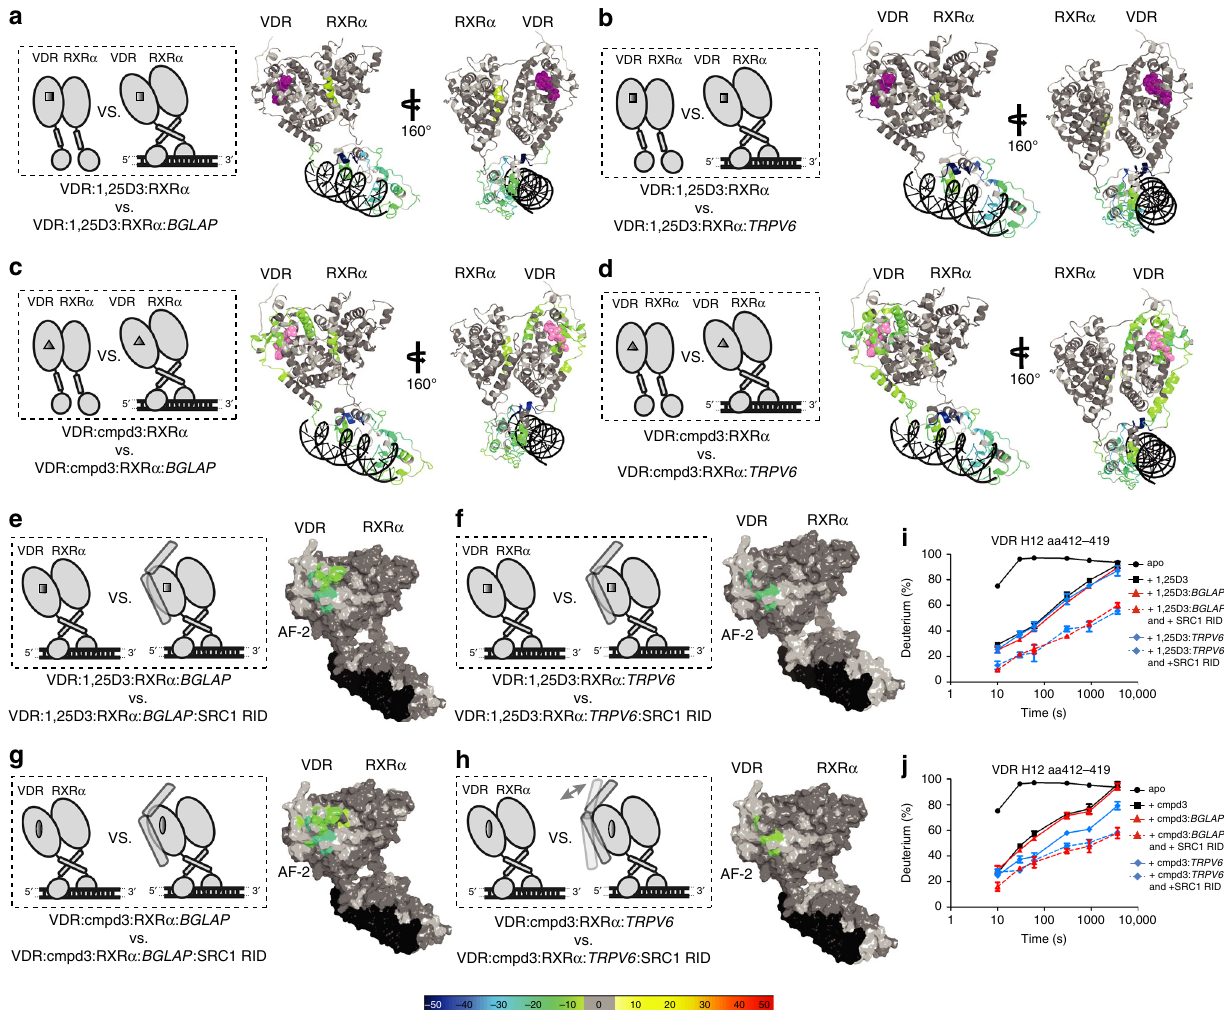
Fig. 5 Activations of VDRRXR α heterodimer with cognate VBS BGLAP and TRPV6 by selective modulator Cmpd3 verse natural ligand 1,25D3. Schematic representations illustrate differential experiments of ligand bound VDRRXR α heterodimer with respect to DNA and SRC1 RID binding (on the left). Differential consolidation HDX data are mapped onto the VDRRXR heterodimer structure model when the complex is bound to different ligands and DNA (shown in ribbon a − d ), and SRC1 RID (shown in surface e − h ) (on the right). Conformational changes of 1,25D3-bound heterodimer upon binding of a BGLAP VBS (Supplementary Fig. 1b, d, column (xvii)) and b TRPV6 VBS (Supplementary Fig. 1b, d, column (xviii)). Conformational changes of selective modulator Cmpd3 bound heterodimer upon binding of c BGLAP VBS (Supplementary Fig. 1b, d, column (xix)) and d TRPV6 VBS (Supplementary Fig. 1b, d, column (xx)). e Conformational changes of VDRRXR α : 1,25D3: BGLAP complex upon SRC1 RID binding (Supplementary Fig. 1b, d, column (xxi)). f Conformational changes of VDRRXR α : 1,25D3: TRPV6 complex upon SRC1 RID binding (Supplementary Fig. 1b, d, column (xxii)). g Conformational changes of VDRRXR α : Cmpd3: BGLAP complex upon SRC1 RID binding (Supplementary Fig. 1b, d, column (xxiii)). h Conformational changes of VDRRXR α : Cmpd3: TRPV6 complex upon SRC1 RID binding (Supplementary Fig. 1b, d, column (xxiv)). Percentages of deuterium differences are coded as Fig. 1. Dark gray, no statistically signi fi cant changes between compared conditions; light gray, regions that have no sequence coverage and include proline residue that has no amide hydrogen exchange activity; black, DNA VBSs; purple, 1,25D3 ligand; pink, Cmpd3. i Differential deuterium uptake plots of peptide aa411 − 419 from VDR H12 when heterodimer is bound to 1,25D3, DNA and SRC1 RID. j Differential deuterium uptake plots of peptide aa411 − 419 from VDR H12 when heterodimer is bound to Cmpd3, DNA, and SRC1 RID. The data are plotted as percent deuterium uptake verse time on a logarithmic